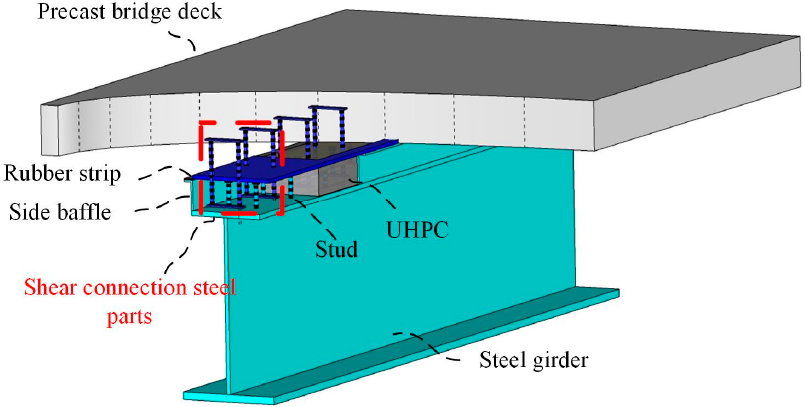
Figure 1. Three-dimensional sketch of PCSC connectors.